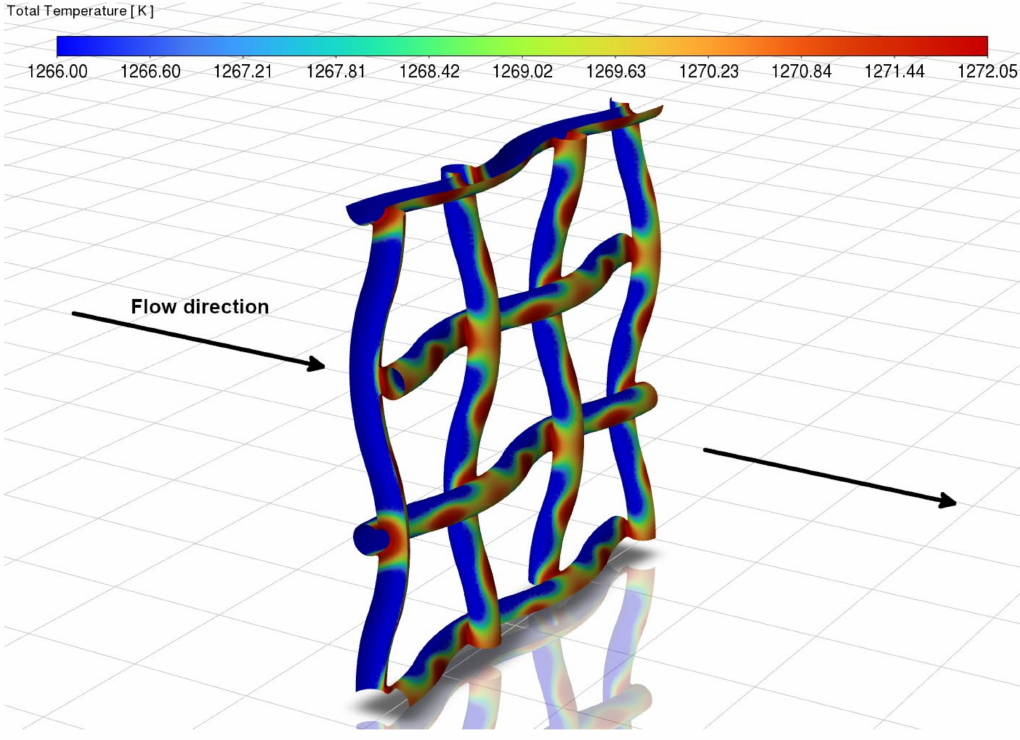
Figure 10. Surface temperature gradient on the first layer of gauze (Geometry A). Platinum particles were released from areas of higher temperature (“hot” zones shown in